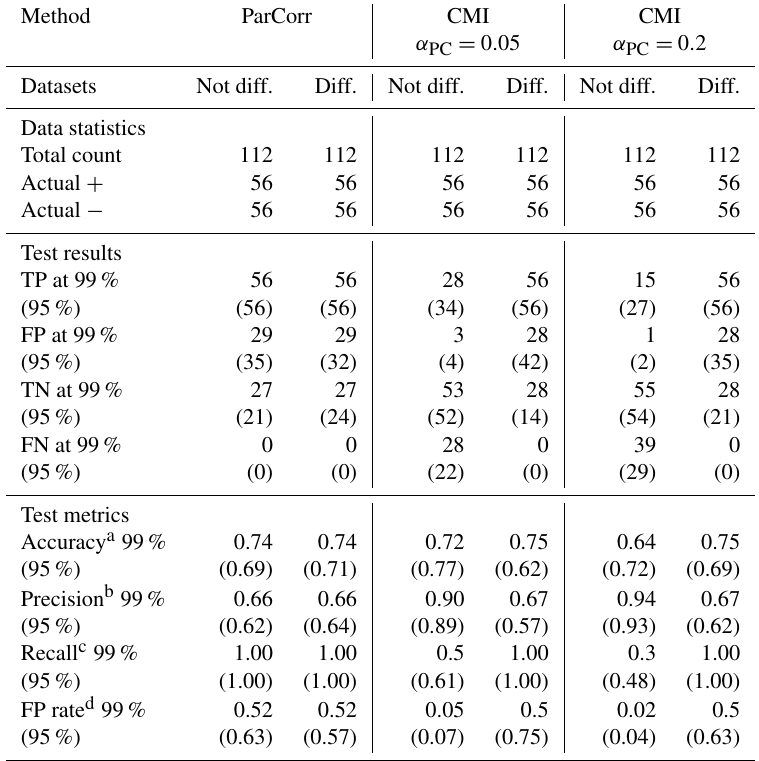
Table 3. Causal test statistics for the synthetic cases at lag 1d.